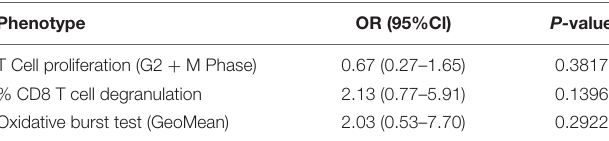
TABLE 5 | Effects of MedDiet on T cell proliferation, CD8 T cell degranulation and granulocyte oxidative burst